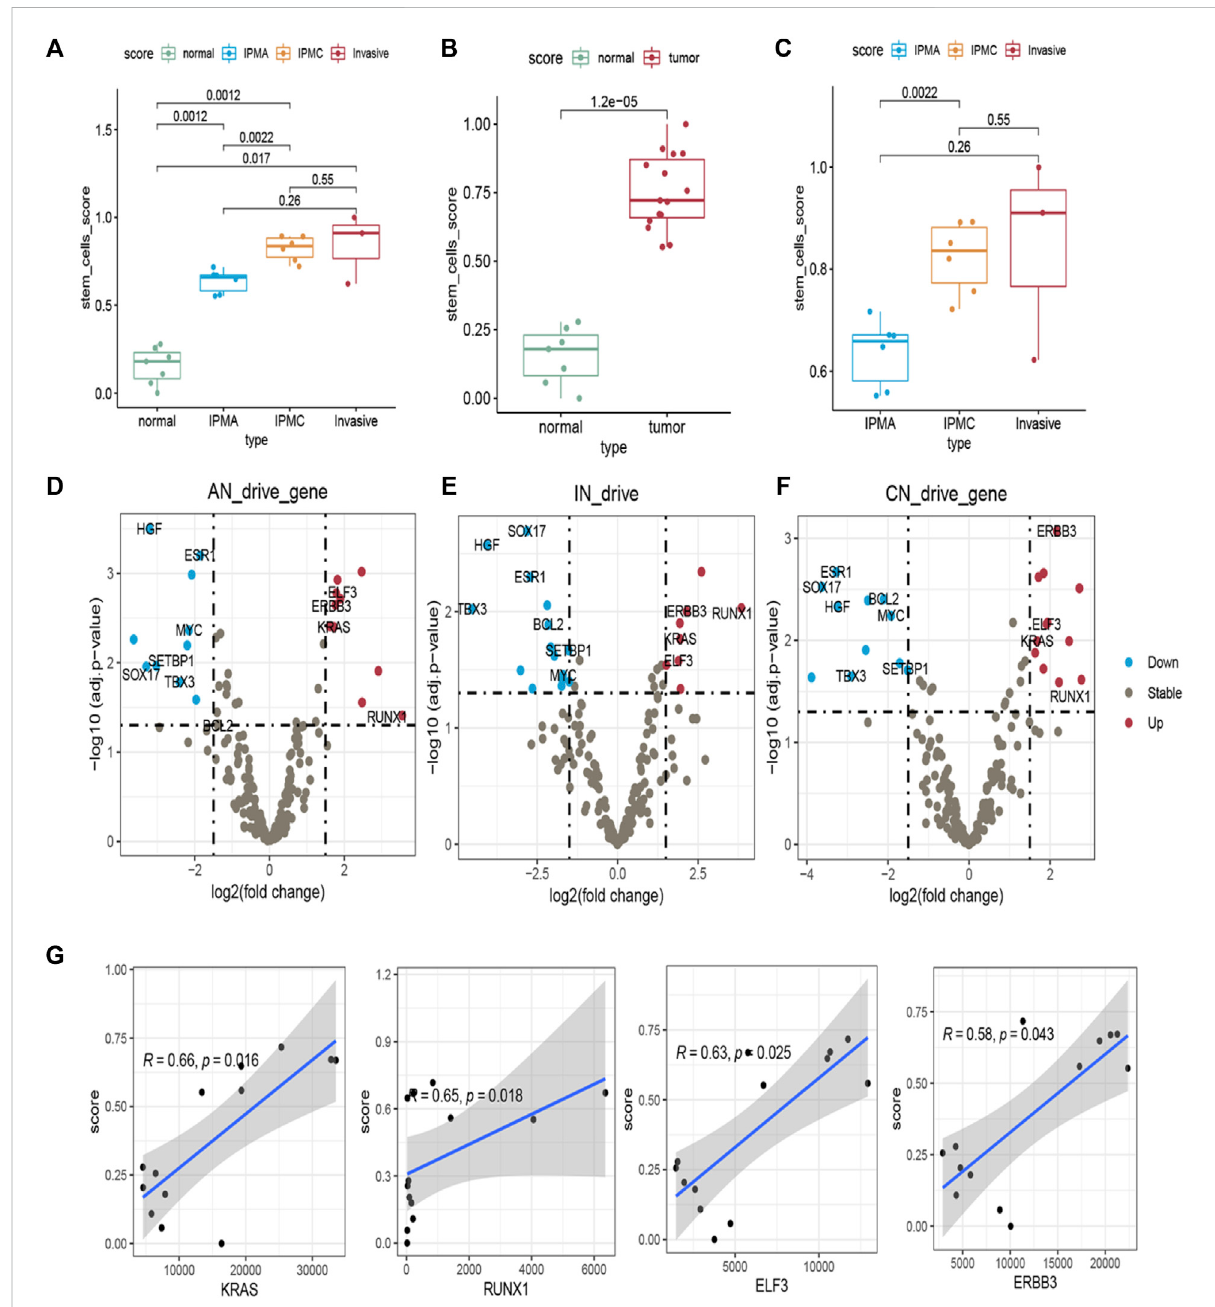
FIGURE 2 Stemness and expression of 299 pan-cancer driver genes in different disease stage tissues. (A – C) Stem scores of different samples. (D – F) Differential expression of 299 pan-cancer driver genes in (D) IPMA, (E) invasive, and (F) IPMC relative to Normal samples. Driver genes with p < 0.05 and fold-change > 1.5 were identi fi ed as up driver genes (red dots). Driver genes with p < 0.05 and fold-change < 1.5 were identi fi ed as down driver genes (blue dots). Other genes were assumed as unchanged driver genes (grey dots). (G) Correlation of stem scores and four consistent changed driver genes in IPMA, IPMC, and invasive